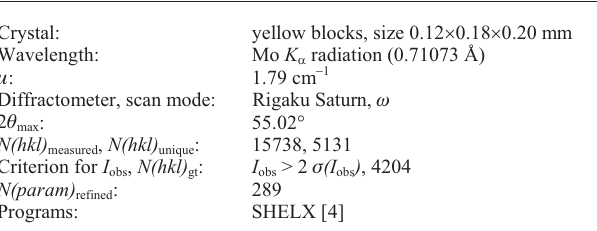
Table 1. Data collection and handling.